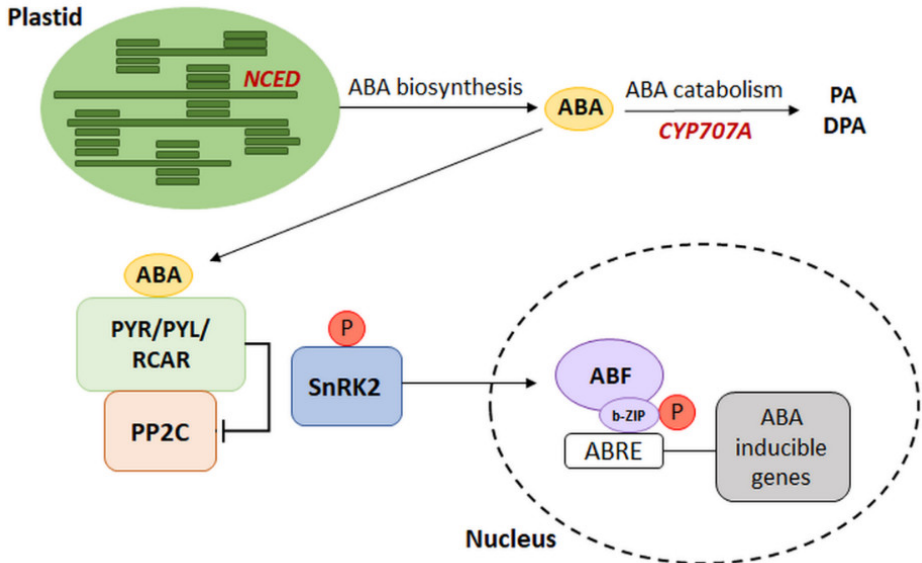
Figure 2. The schematic model of connection between ABA metabolism and transduction pathways. NCED: 9- cis -epoxycarotenoid dioxygenase, CYP707A: ABA 8’-hydroxylase, PA: phaseic acid, DPA: dihydro phaseic acid, ABRE: ABA-responsive element, ABF: ABRE binding factor with b-ZIP—leucine zipper domain, PYR/PYL/RCAR: ABA receptors, PP2C: type 2C protein phosphatase (negative regulator), SnRK2: sucrose non-fermenting 1 (SNF1)-related protein kinase 2 (positive regulator), P: phosphorylation. (Modified from [14]).